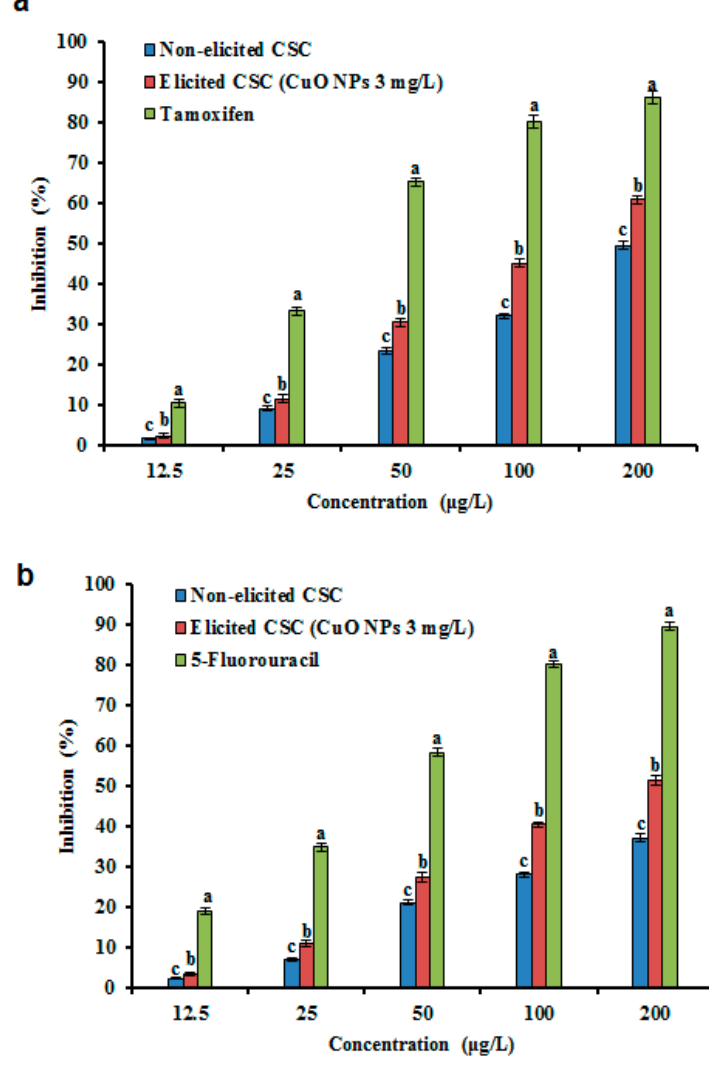
Figure 7. E ff ect of CuO NPs on cell viability of MCF-7 cells ( a ) and HT-29 cells ( b ) in CSC of G. sylvestre . Figure 7. Effect of CuO NPs on cell viability of MCF ‐ 7 cells ( a ) and HT ‐ 29 cells ( b ) in CSC of G. Di ff erent letters indicate a significant di ff erence at p ≤ sylvestre . Different letters indicate a significant difference at p ≤ 0.05.